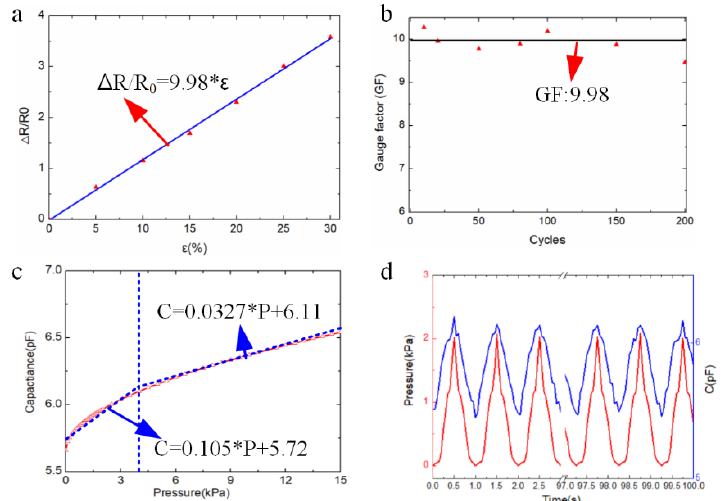
Figure 4. Electrical performance of RES. ( a ) Variable resistance value versus the strain. ( b ) Repeated strain data with different loading cycles. ( c ) Relationship between the capacitance and external pressure. ( d ) Repeated capacitance data with different loading cycles.